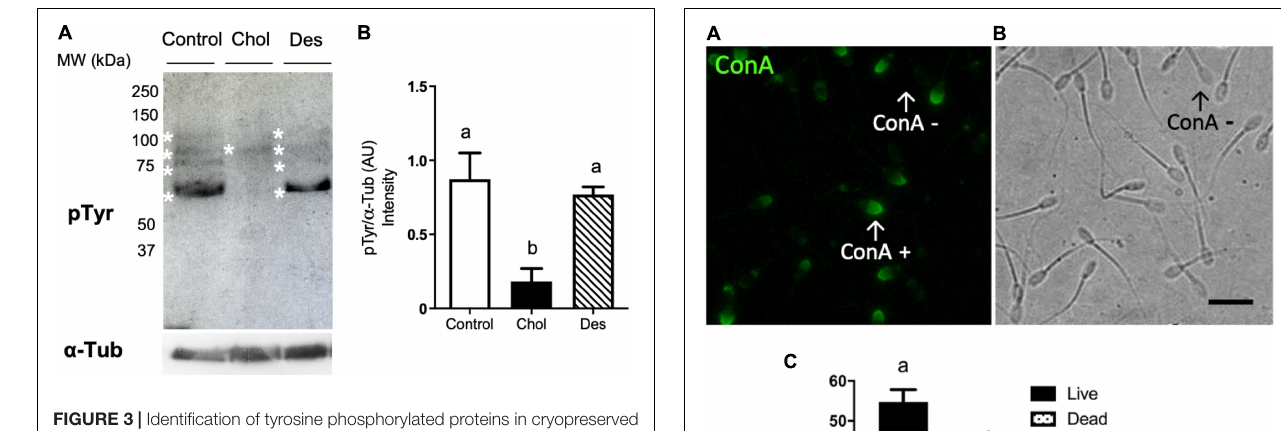
FIGURE 3 | Identification of tyrosine phosphorylated proteins in cryopreserved ram sperm pre-treated with 10 mM M β CD-Chol (Chol) or -Des (Des). Proteins were resolved by SDS-PAGE (12.5%), blotted using an anti-phosphotyrosine (pTyr) antibody and immunoreactive bands were revealed by chemiluminescence. (A) Representative set of the experimental groups showing pTyr detection. Asterisks indicate position of the different phospho-proteins. Each lane corresponds to 5 × 10 6 spermatozoa. Constitutive α -Tubulin ( α -Tub) was used as loading control (lower panel). (B) Quantification of total intensity of immunoreactive bands per lane measured by densitometry (Fiji software) and expressed as arbitrary units (AU). Bars represent mean values ± SEM ( N = 4). Data were analyzed by Kruskal-Wallis test. Different letters (a, b) indicate significant differences ( p < 0.05). FIGURE 4 | Effect of sterol incorporation on acrosome integrity after